Question: Sum up the contents of this chart in one sentence.
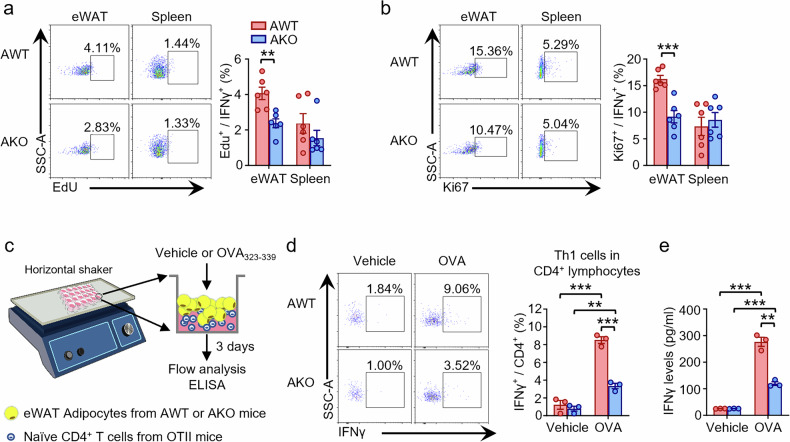
Answer: Adipocyte OX40L–OX40 signalling drives Th1 cell differentiation in adipose tissue. a Flow cytometry analysis of EdU + Th1 cell populations in epididymal white adipose tissue (eWAT) and spleen from 12-week high-fat-diet (HFD)-fed adipocyte-specific OX40L knockout (AKO) and littermate control (AWT) mice ( n = 6 per group). b Flow cytometry analysis of Ki67 + Th1 cell populations in eWAT and spleen from 12-week HFD-fed AKO and AWT mice ( n = 6 per group). c Schematic of adipocyte–naïve CD4 + T cell co-culture experiment. d Flow cytometry analysis of Th1 cell proportions in co-culture systems ( n = 3 per group). e ELISA quantification of IFNγ levels in co-culture supernatants ( n = 3 per group). Data represent mean ± SEM. ** P < 0.01 and *** P < 0.001.